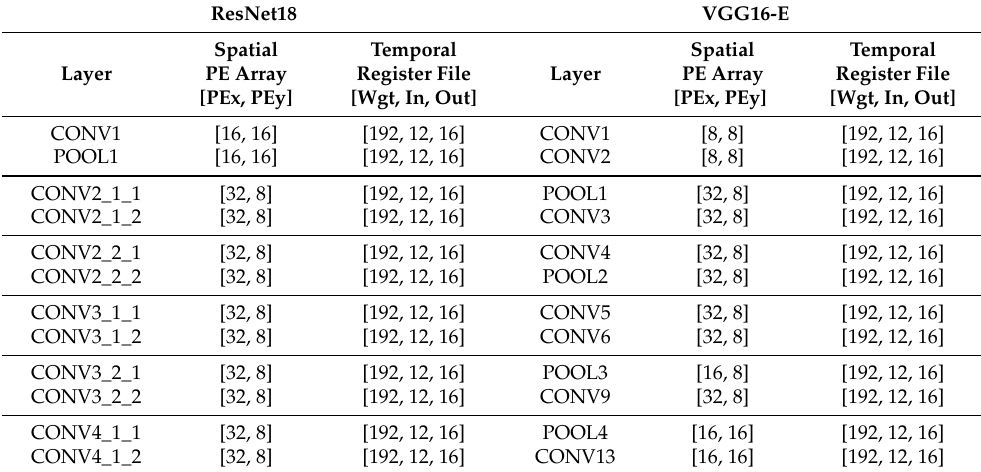
Table 6. HW resource partitioning found by the scheduler for ResNet18 and VGG16-E layers. Only PE array partitions are actually searched, as the register file sizes are fixed during the